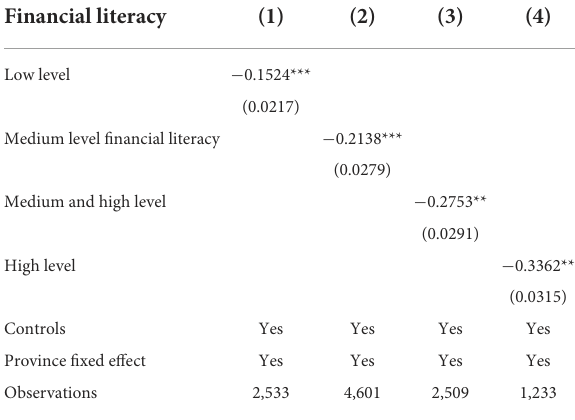
TABLE 10 Further analysis: different financial literacy